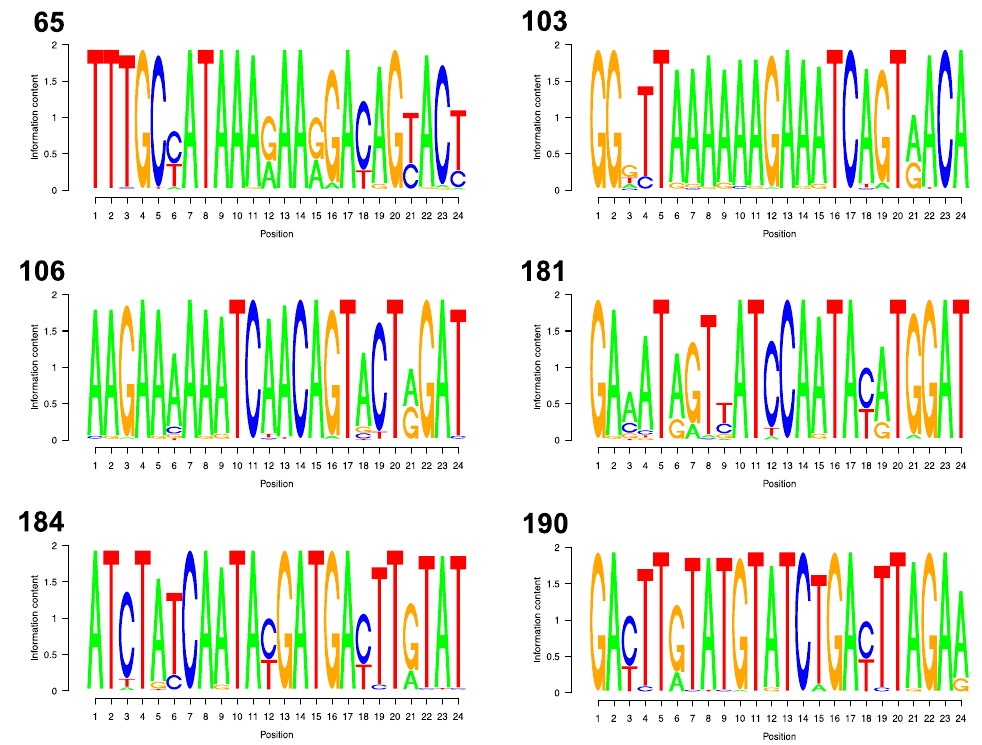
Figure 2. For each DRM Position, the variability at each of the 24 nucleotide positions making up the flanking segments are shown. The letter(s) shown at each nucleotide position indicate which of the four nucleotides are found at that position among all low and middle income country sequences. The relative sizes of the letters indicate their frequency at the position that was weighted by the information content of the position. Therefore, the combined height of the letter(s) in each nucleotide position corresponds to the information content of the position.